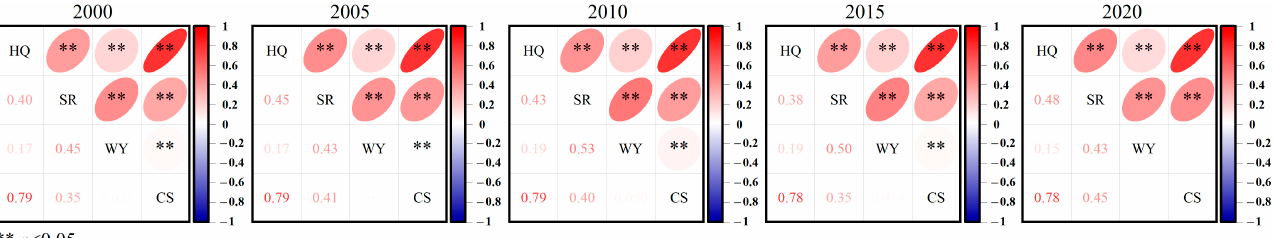
Figure 4. Trade-off s and synergies of ESs over time. Figure 4. Trade-offs and synergies of ESs over